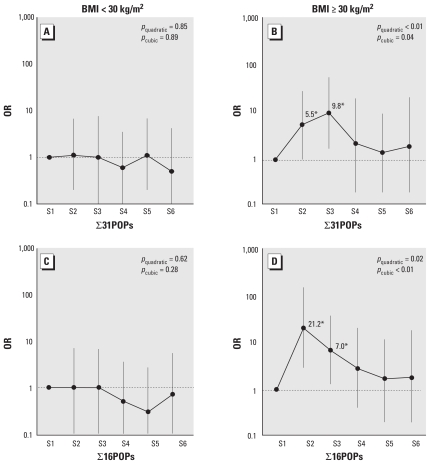
Adjusted ORs and 95% CIs of incident diabetes according to sextiles of the summary measure formed from serum concentrations of all 31 POPs (∑31POPs; A, B) or 16 selected POPs (∑16POPs; C, D) (trans-nonachlor + oxychlordane + mirex + PBB153 + 12 PCBs) with ORs ≥ 1.5 in the second quartile in Tables 3 and 4 stratified by year 2 BMI. Lipid-adjusted model, that is, adjusted for age, sex, race, BMI, triglycerides, and total cholesterol at year 2.*Significantly different from 1, p < 0.05.